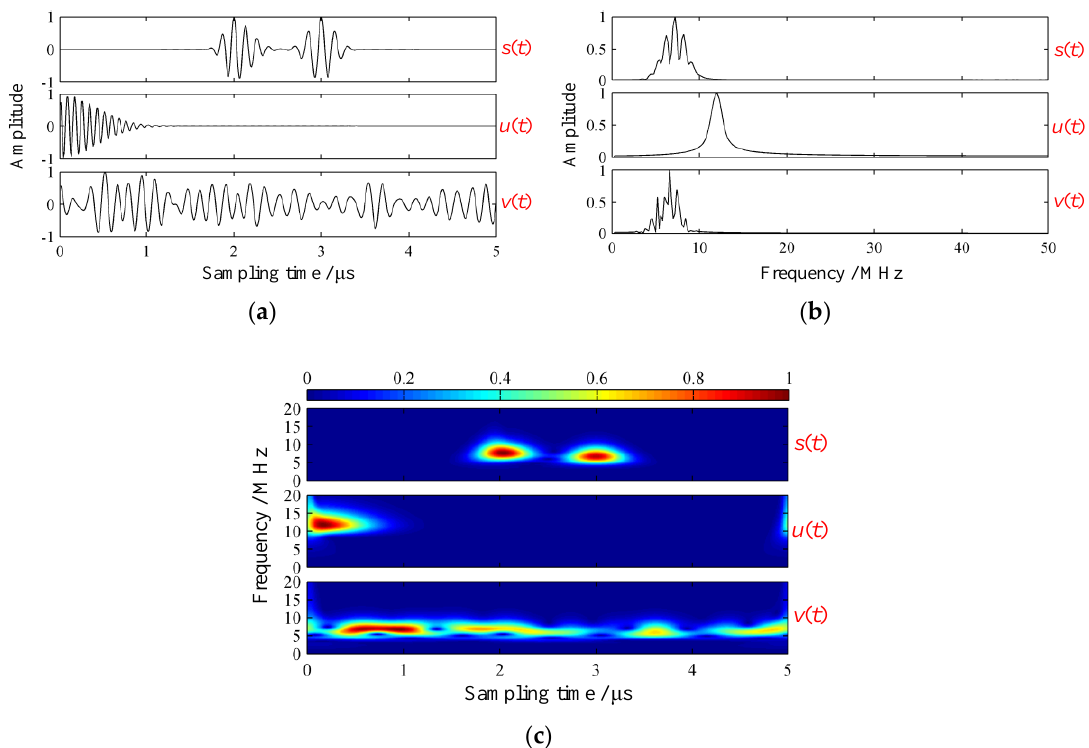
Figure 6. Simulated results of a simplified backscattered signal model. ( a ) Waveforms; ( b ) spectrums; and ( c ) GST spectrums.